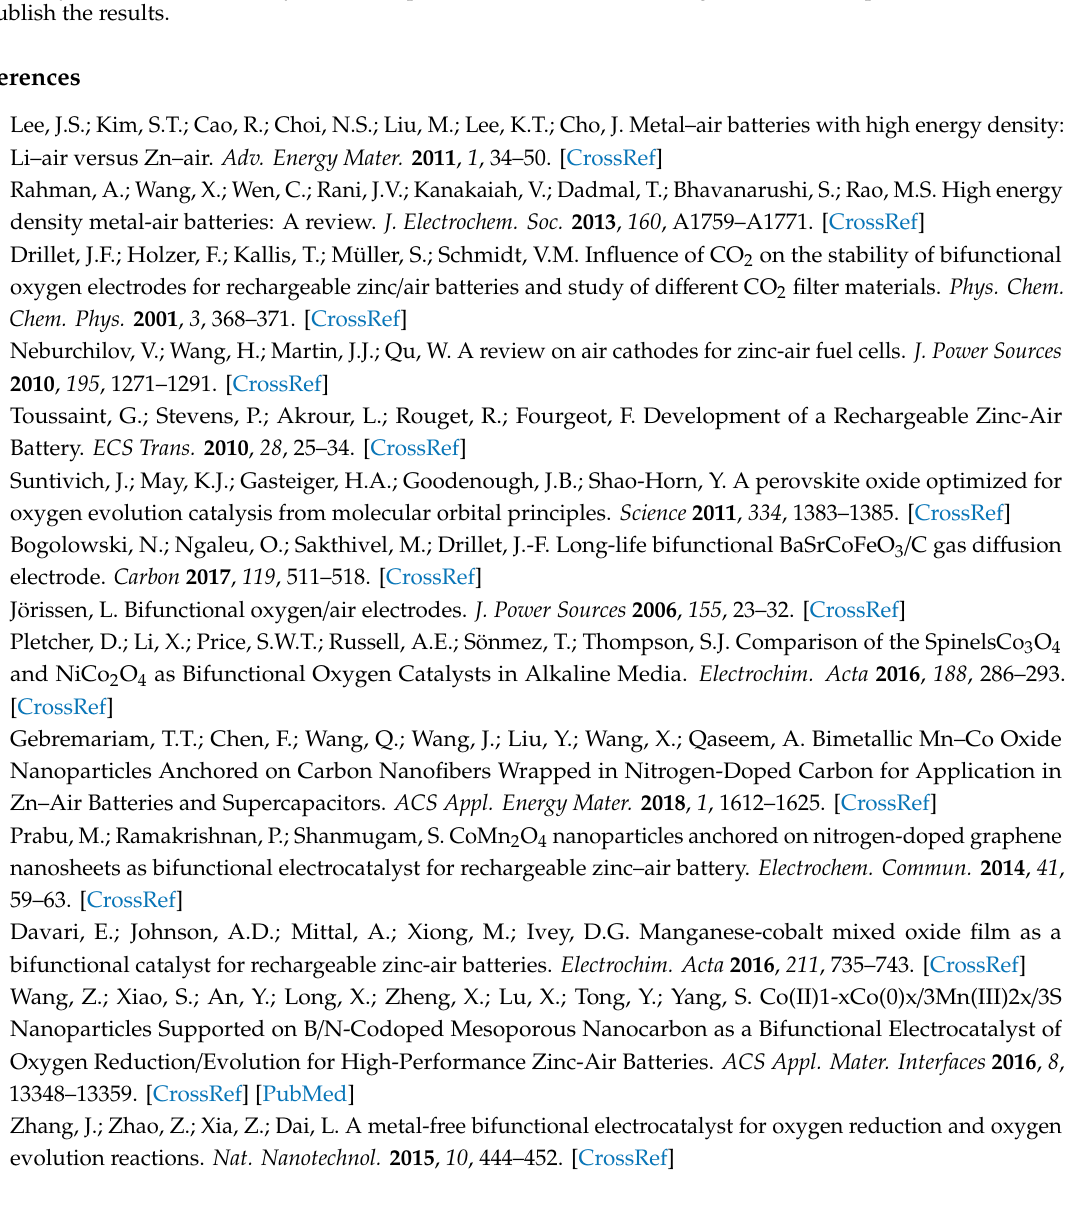
Table S1: Physicochemical properties of di ff erent water / ChAcO mixtures at 20 ◦ C, Table S2: List of OCV values from di ff erent Zn / air